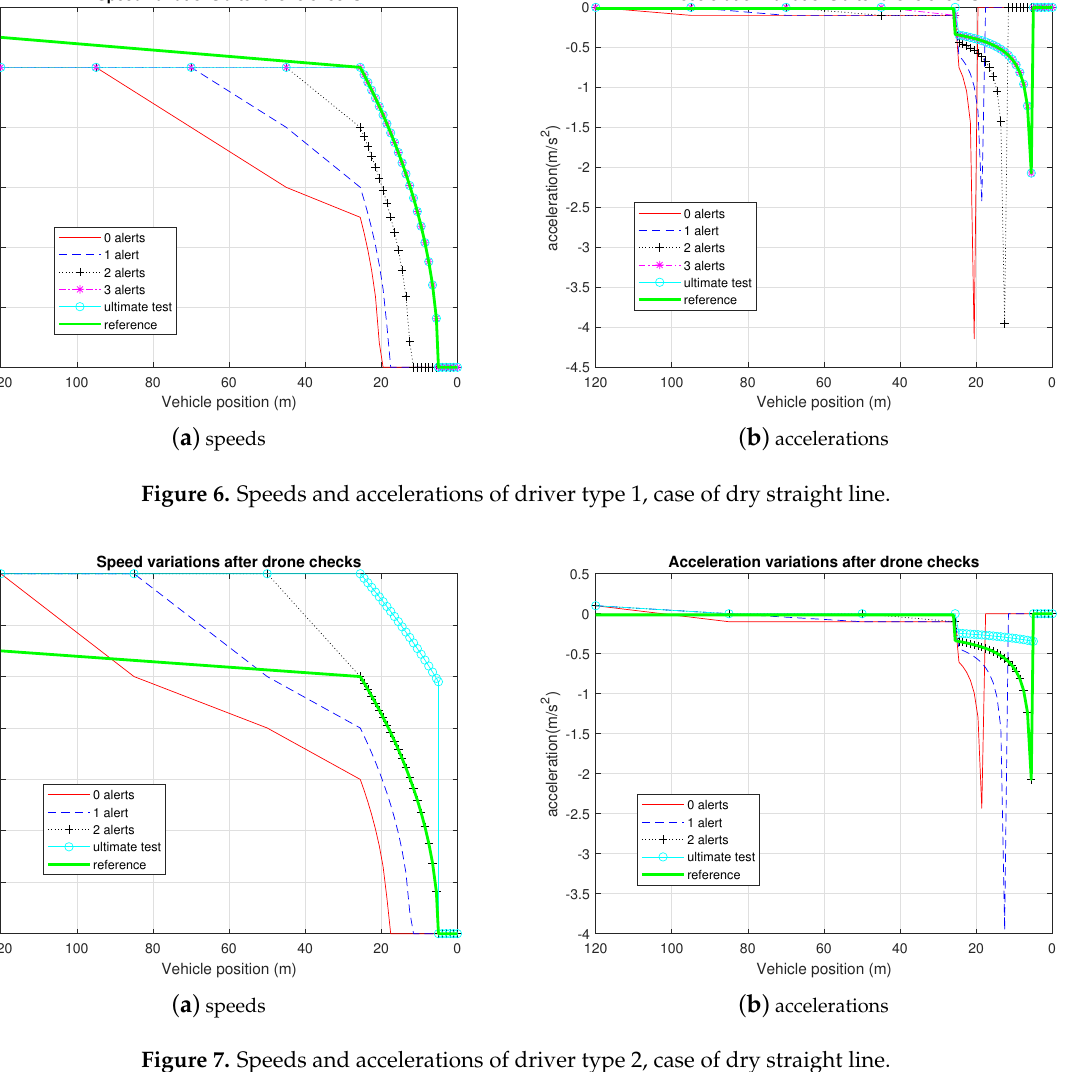
Figure 7. Speeds and accelerations of driver type 2, case of dry straight